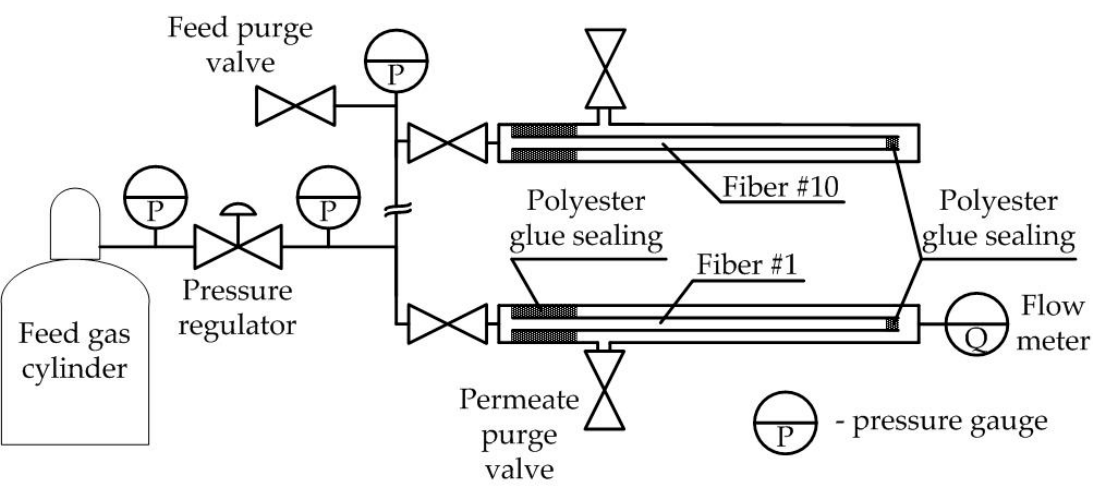
Figure 2. The setup of the pure gas permeance measurement.